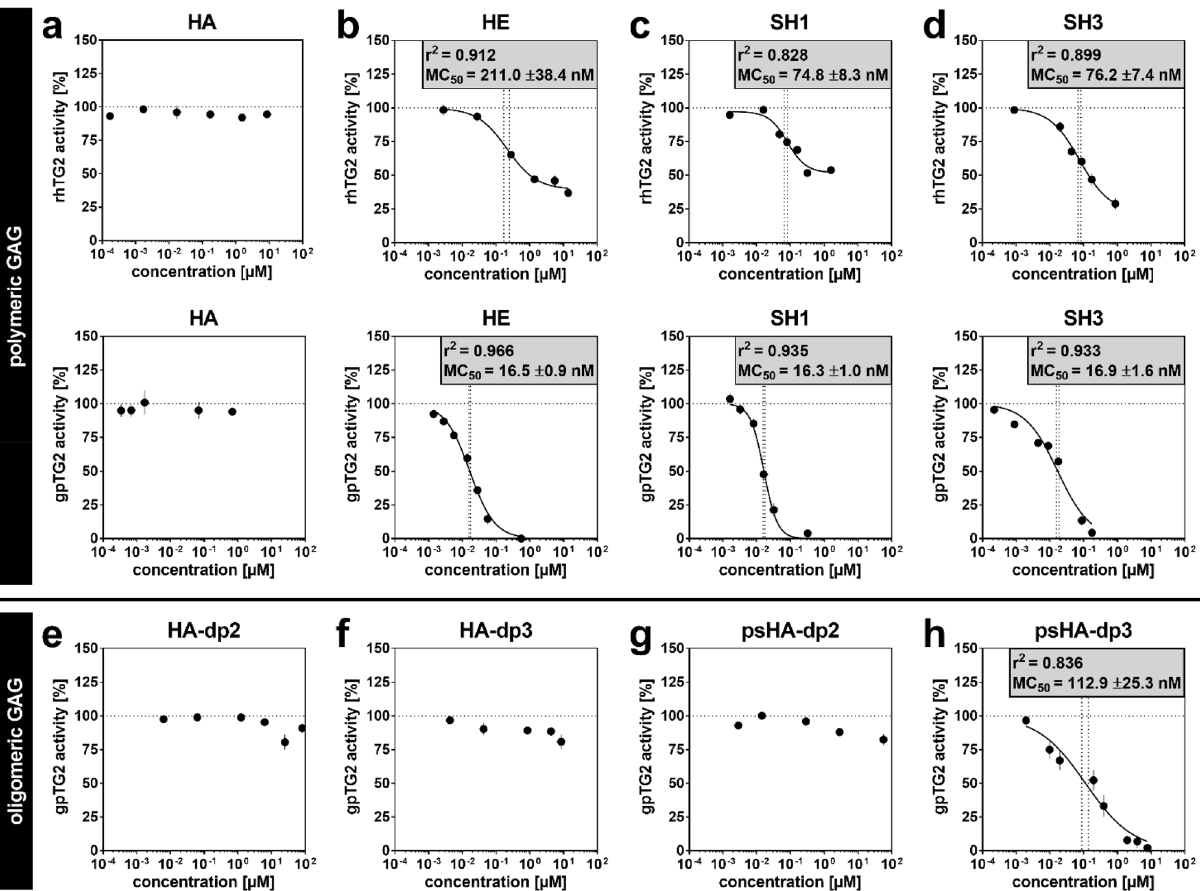
Figure 1. Influence of GAG derivatives on TG2 enzymatic crosslinking activity. rhTG2 (top) and gpTG2 (middle) were pre-incubated with polymeric GAG derivatives ( a – d ) and applied to TG2 activity assay as described: ( a ) HA, ( b ) HE, ( c ) SH1 and ( d ) SH3. Furthermore gpTG2 (bottom; e – h ) was incubated with HA oligosaccharides and applied to TG2 activity assay as described: ( e ) HA-dp2, ( f ) HA-dp3, ( g ) psHA-dp2 and ( h ) psHA-dp3. Positive control (i.e. TG2 activity without any treatment) was set to 100%. Values are shown as mean ± SEM; n = 3. MC 50 values were calculated according to non-linear fit (black line). Vertical dotted lines indicate the range of MC 50 ±